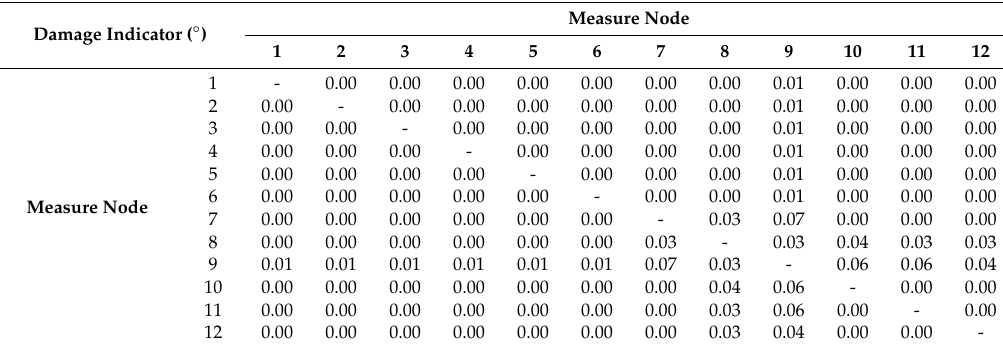
Table 3. Damage indicator of case 1_2 using the SVR